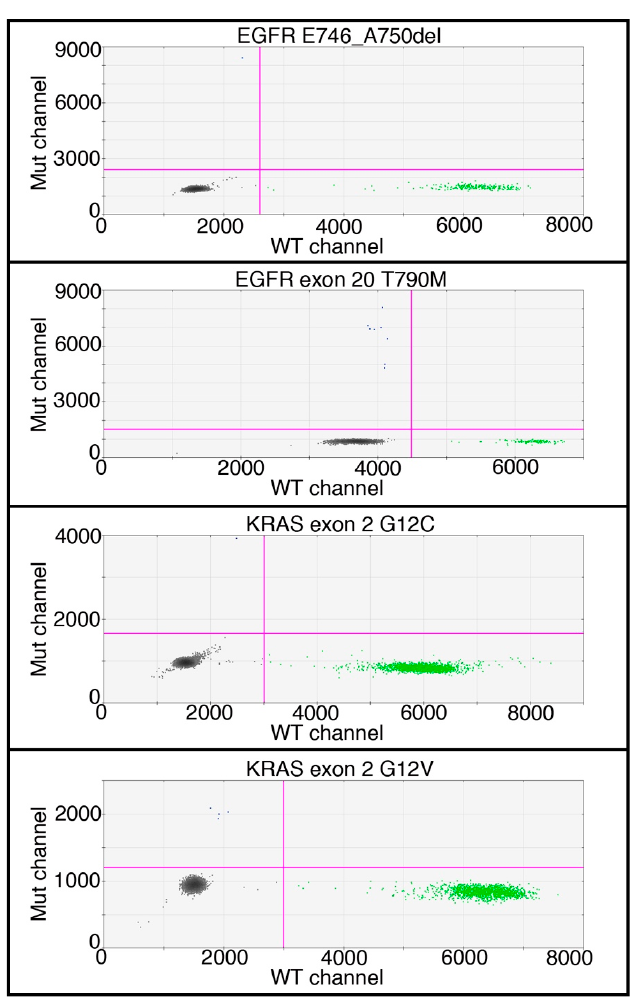
Figure 8. 2-dimensional dot-plots showing the results of ddPCR of four representative patients in which mutated DNA was detected. In Y -axis: intensity of FAM dye tagging mutated DNA (Mut channel); in X -axis: intensity of HEX dye tagging wild type DNA (WT channel). Grey droplets are empty, green droplets contain wild type DNA, and blue droplets contain mutated DNA. Mutant DNA copies were found in 85% of patients with known mutations on primary tumor (22/26) and in 50% of cases of patients with a wild type primary tumor (2/4) (Table 3). Table 3. Comparison between the mutations found in the primary tumor and in the 2-NBDG(high) sorted fraction. In bold, we highlighted the mutations detected in the cells that were different or additional with respect to those found in the primary tumor.